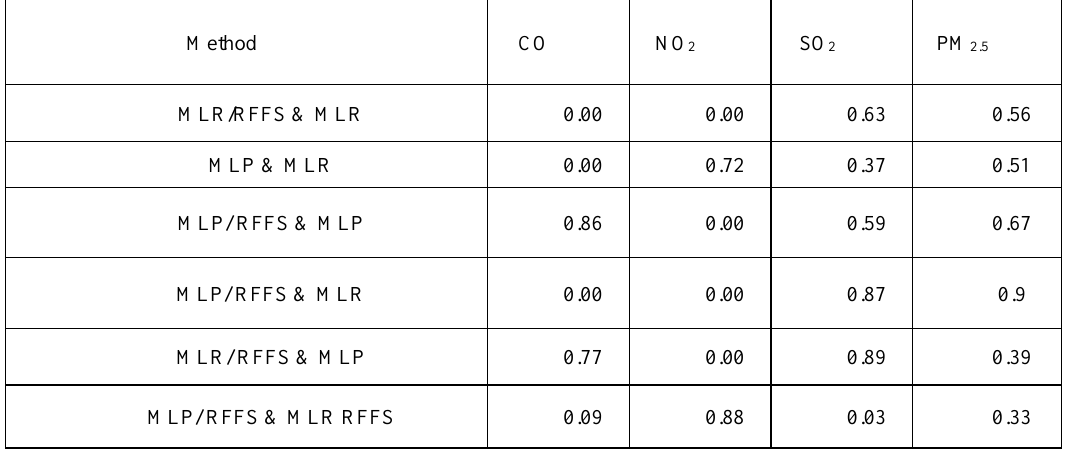
Table 3. The p-values derived from the paired samples